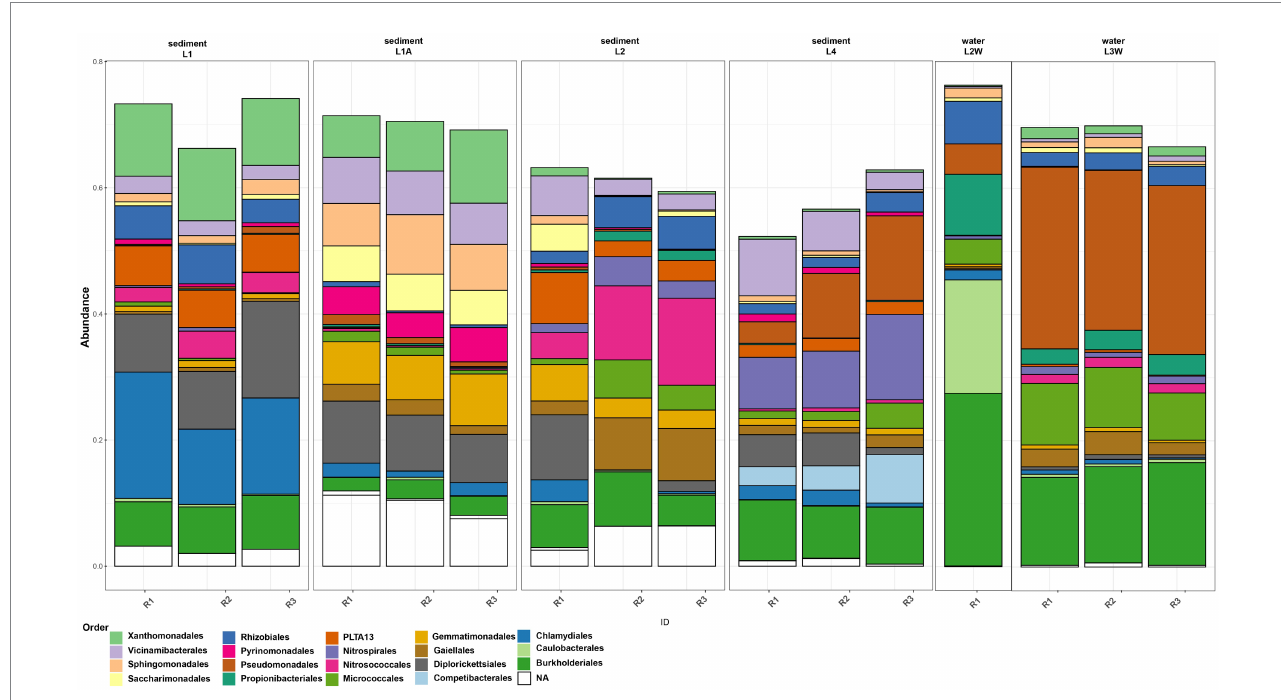
FIGURE 3 Order-level abundances of the microbial communities from sediments and water in Leșu Cave. Orders with a minimum of 5% abundance are